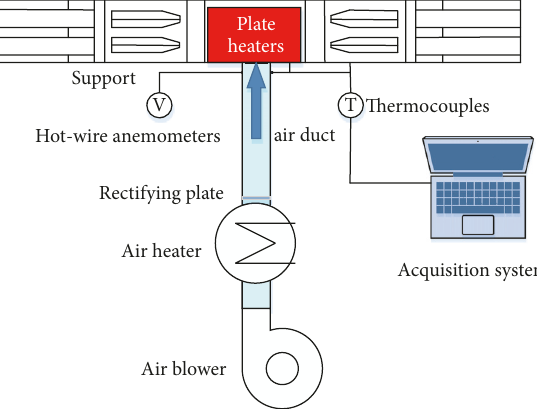
Figure 4: The schematic diagram of experimental